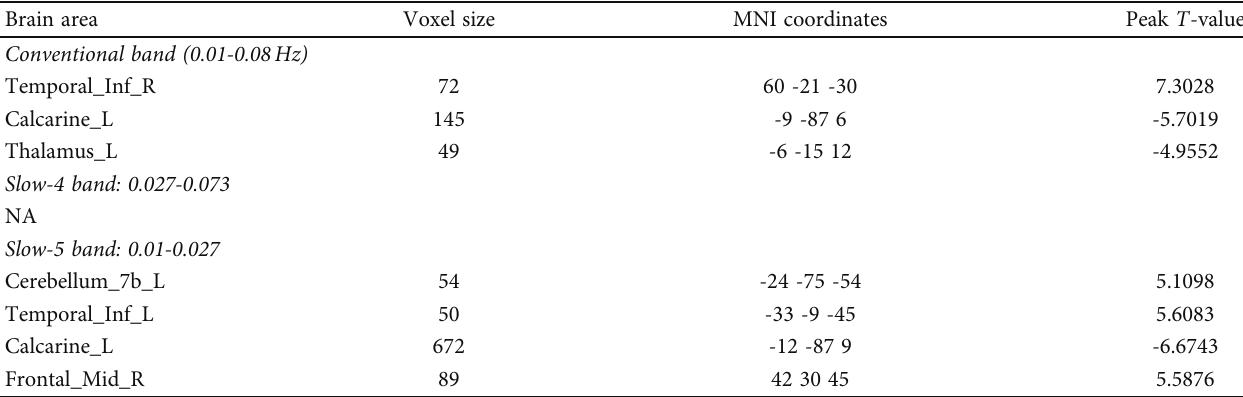
Table 3: Di ff erence in brain regions of mfALFF between stroke patients before treatment and healthy controls. Brain